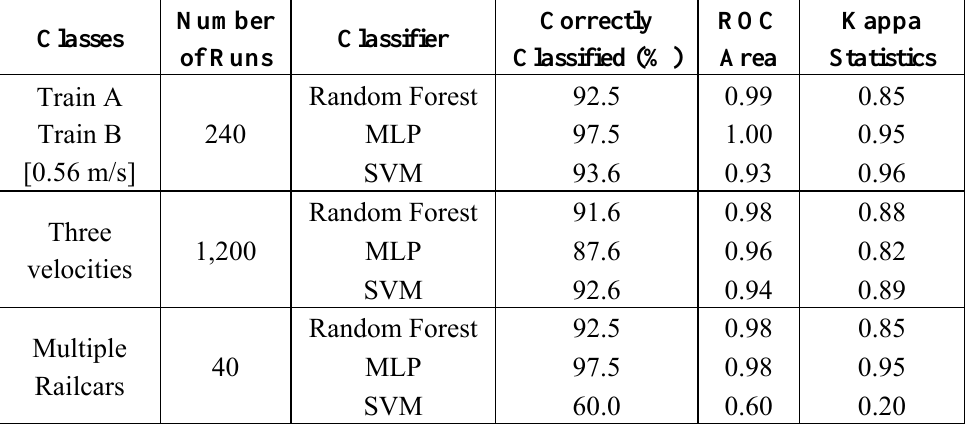
Table 6. Classification results using vibration data.